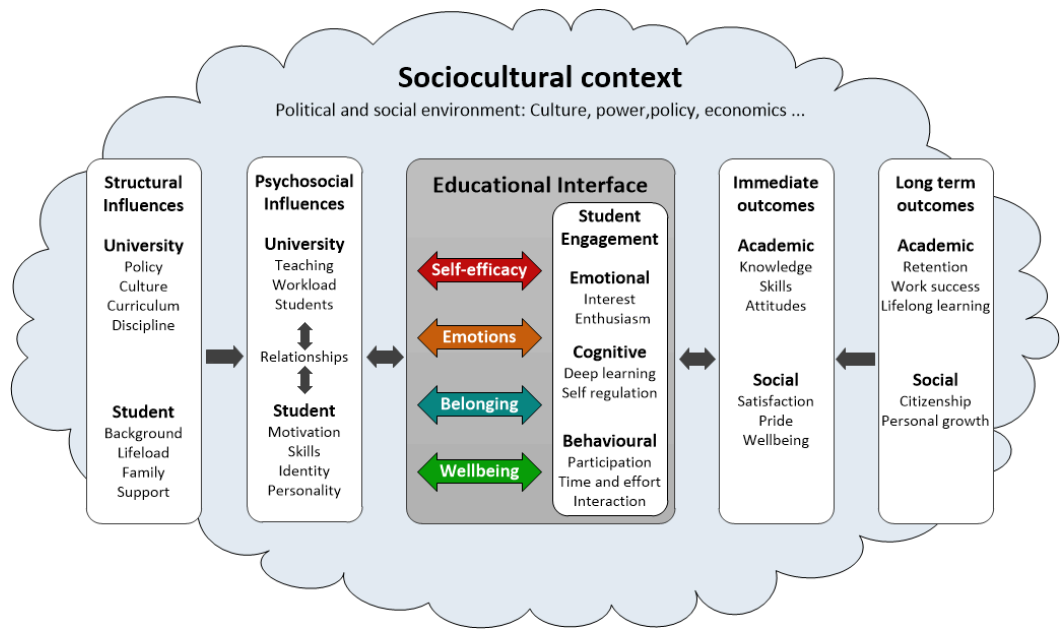
Framework of Student Engagement (Kahu & Nelson, 2018, p.